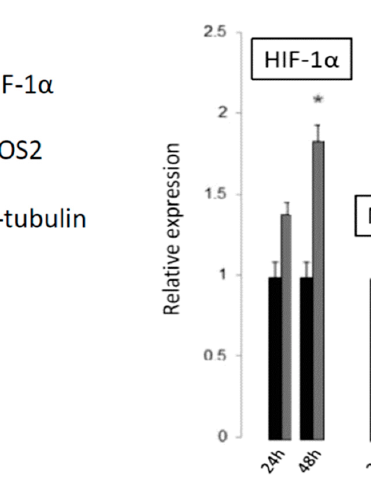
Figure 4. Western blot analysis of predicted protein targets of compounds 4e . Representative western blots are shown on the left panel, where cellular levels of selected proteins before and after treatment of MCF-7 cells with compound 4e , at IC50 = 6.72 µ M for 24 and 48h, can be observed. C denotes control (untreated) cells. Approximate molecular weights (kDa) of target proteins are presented. Relative signal intensities of target proteins were normalized to the alpha-tubulin loading control and are shown in the right panel. Data are presented as mean values ± SDs. Statistically significant ( p < 0.5) differences in the expression levels are marked by an asterisk (*).